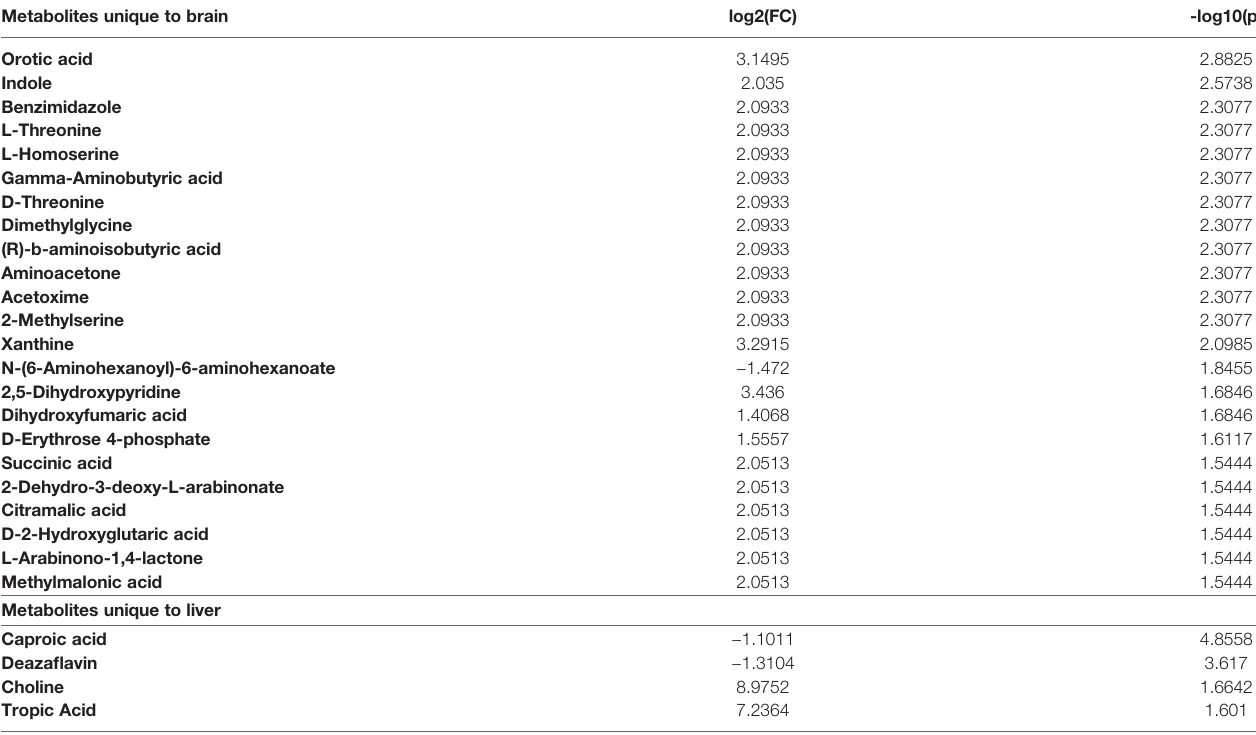
TABLE 1 | Unique metabolites identi fi ed in Brain and Liver (Control vs infected).